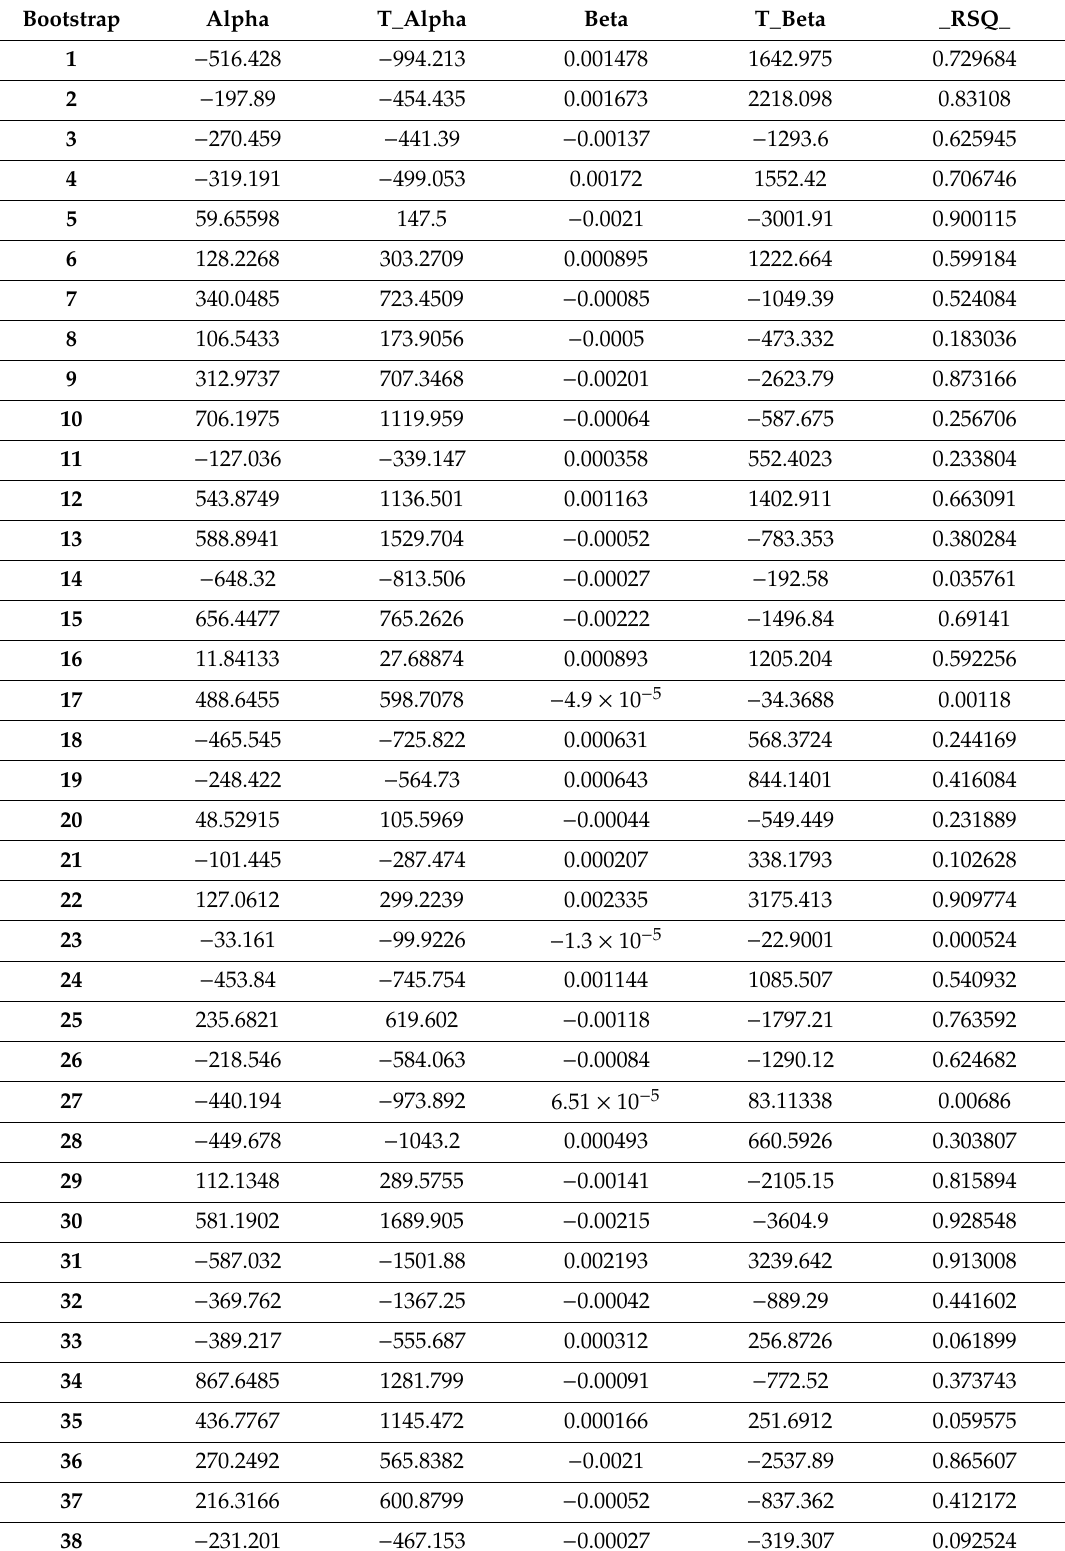
Table A2. Simulation Results (Using a sample size of a million